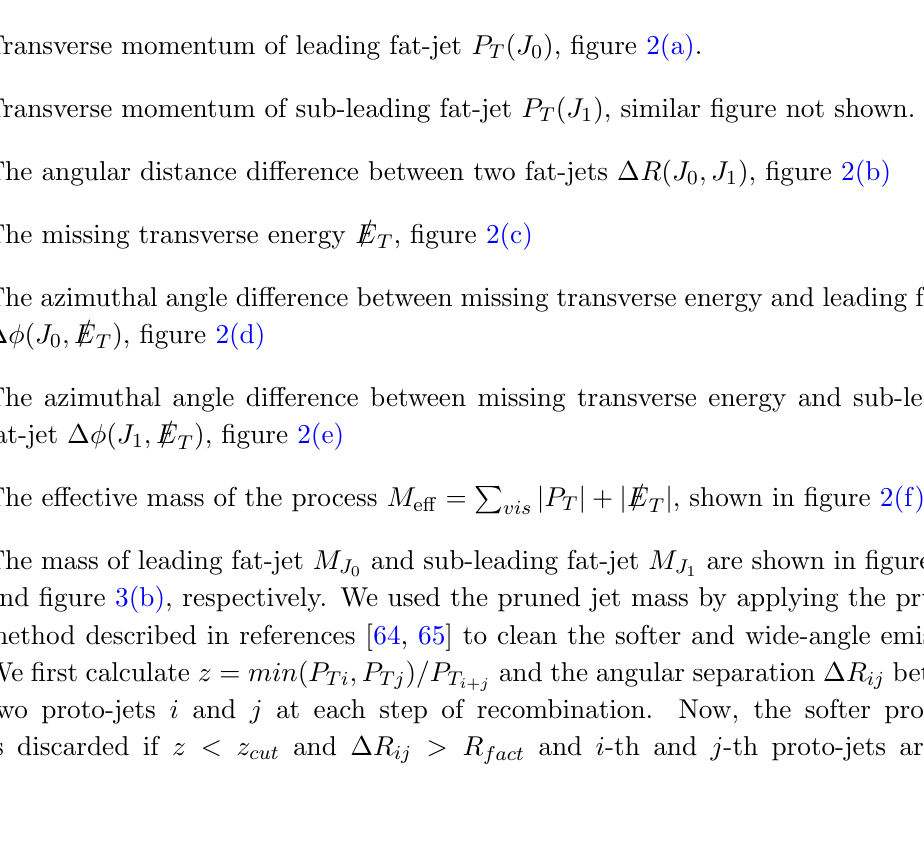
Figure 3 . Normalized distributions of the additional input high level variables constructed for the fat-jets at the LHC ( p s = 14 TeV) used in the MVA for the signal (red) and the background (blue). Signal distributions are obtained for benchmark point BP1 and the background includes all the dominant